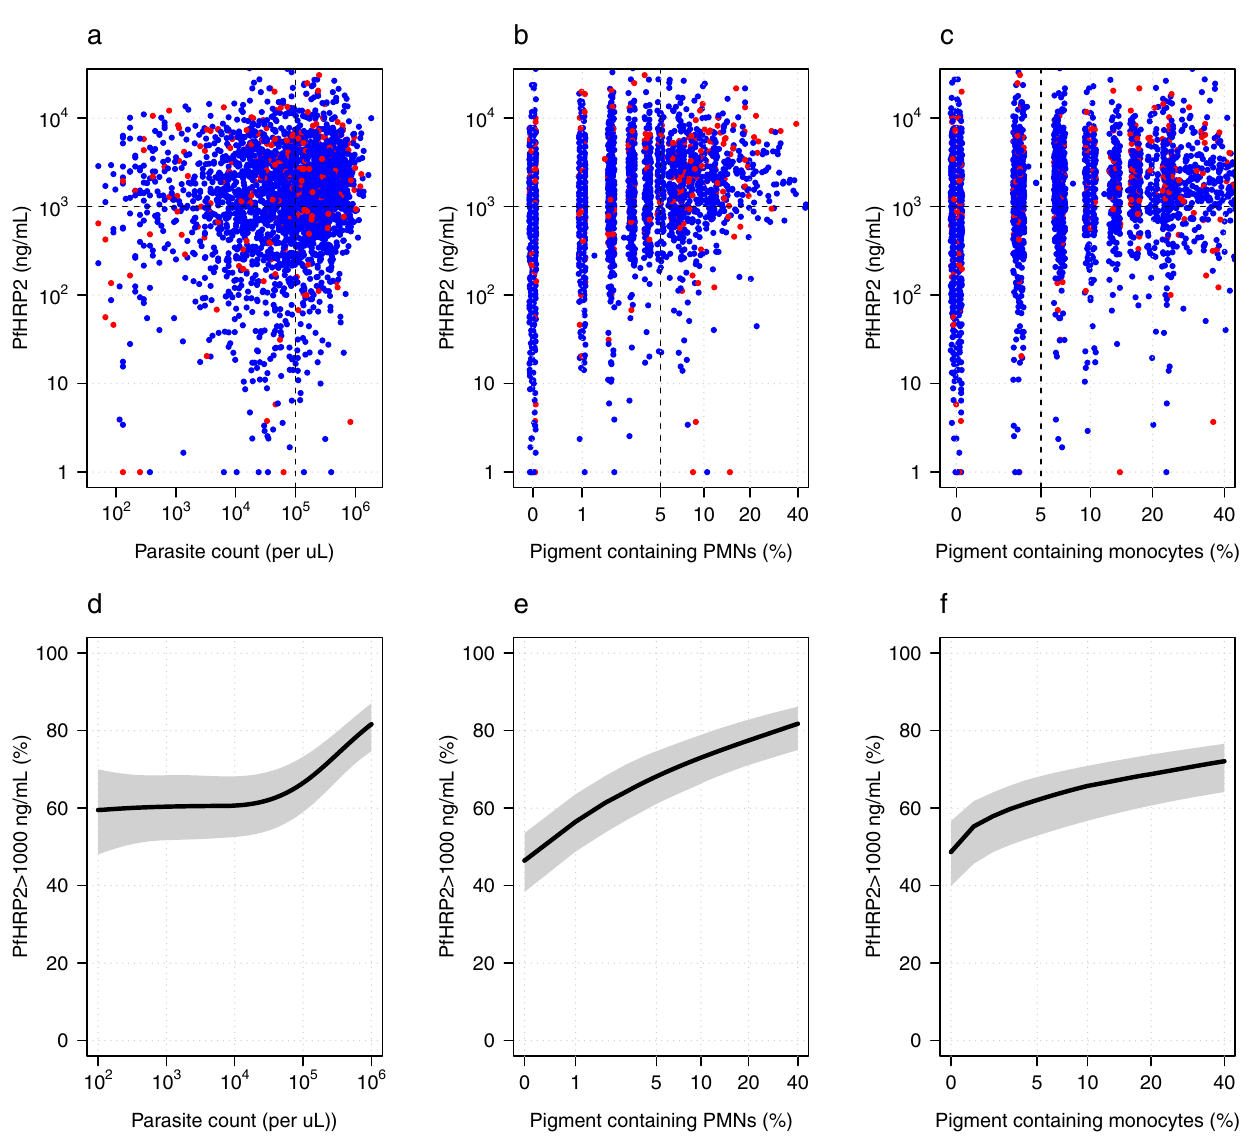
Fig. 6 | The diagnostic value of the parasite count, pigment-containing PMNs (polymorphonuclearleukocytes)andmonocytesinseverefalciparummalaria. Panels a – c show scatterplots ofthe parasite count and the proportions ofpigment containing PMNs and monocytes, respectively, against the plasma Pf HRP2 con- centrations in the 2933 patients from the AQUAMAT trial who had all